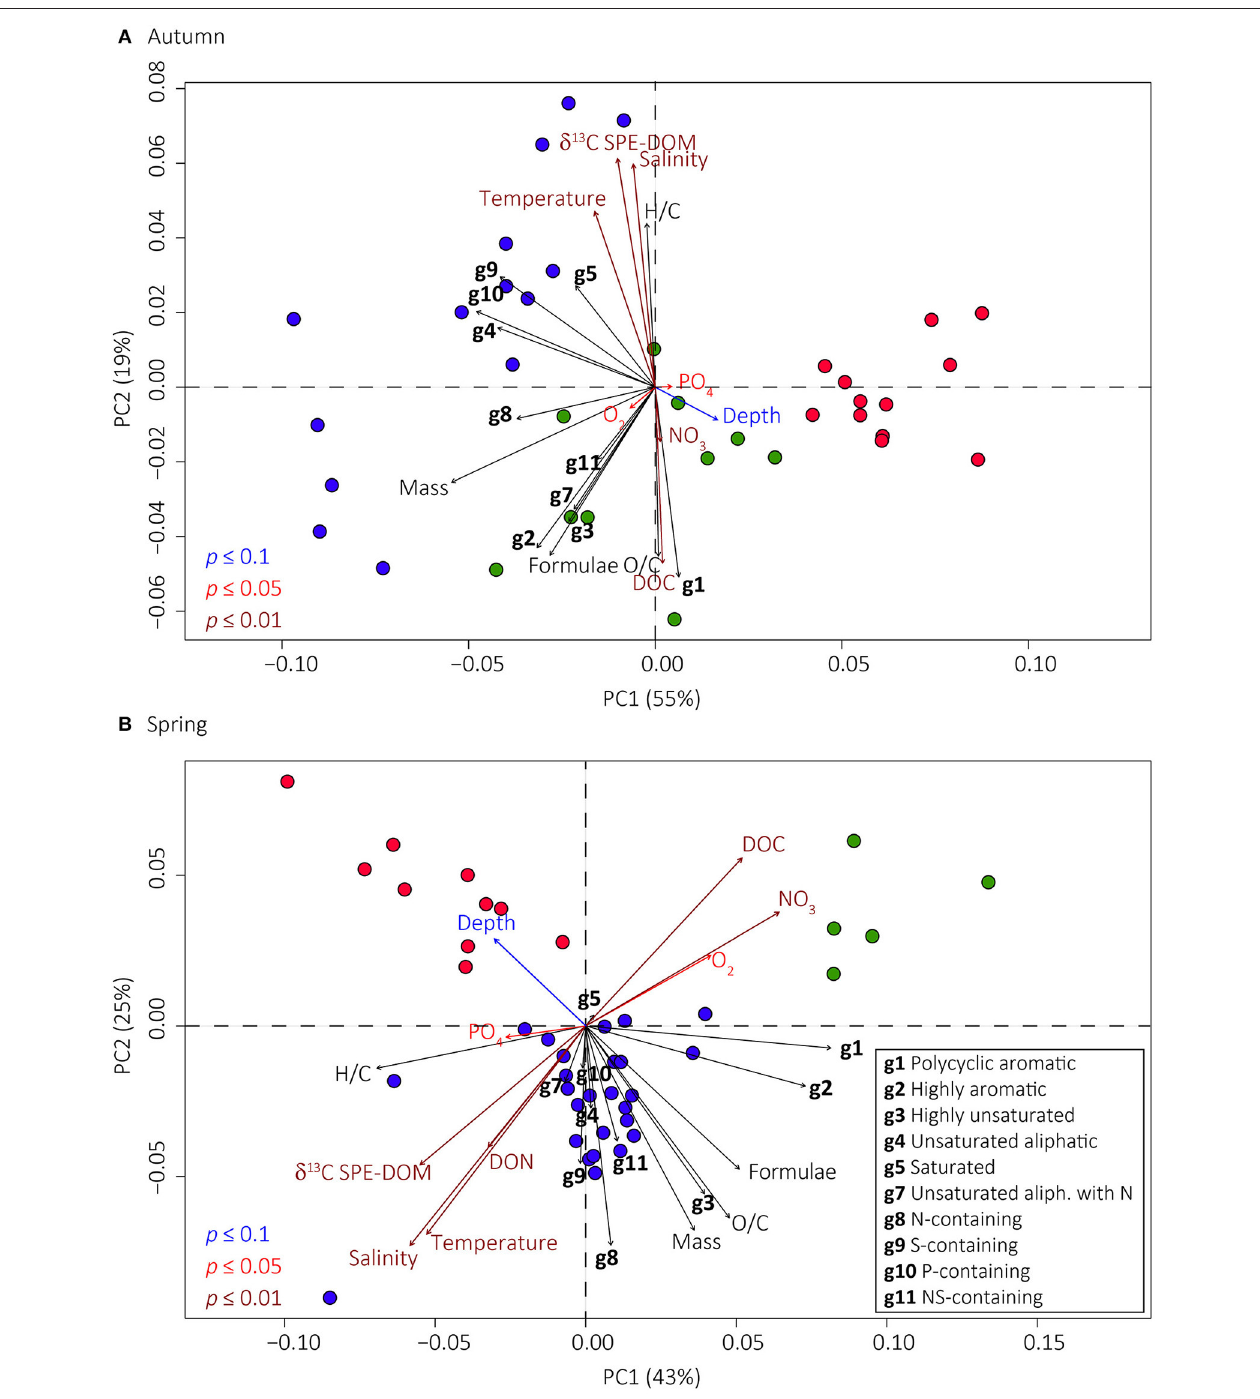
FIGURE 7 | Principal coordinate analyses (PCoA) based on Bray-Curtis dissimilarities of the relative abundance of DOM molecular formulae. Shown are the PCoA for autumn (A) and spring (B) samples, respectively. The percentages give the DOM molecular variability as explained by the axes. Colored circles identify the three main DOM clusters that were found in terrestrial-oxic (green circles), marine-to-brackish oxic (blue circles), and brackish suboxic-to-anoxic conditions (red circles). Environmental parameters (significantly correlated with p ≤ 0.1, p ≤ 0.05, and p ≤ 0.01 blue, red, and dark red arrows, respectively), DOM compound groups (groups g1–g10 specified in legend shown in B ; black arrows) and intensity weighted averages of O/C or H/C ratios and masses (“O/C,” “H/C,” “Mass”) and average number of molecular formulae per sample (“Formulae”) were fitted onto the ordination. Correlations with compound group 6 (saturated compounds with high O/C ratios) were not significant and are therefore not shown. The projections of sampling points onto the vector arrows show maximum correlations with the corresponding molecular compound groups, environmental, and molecular parameters.